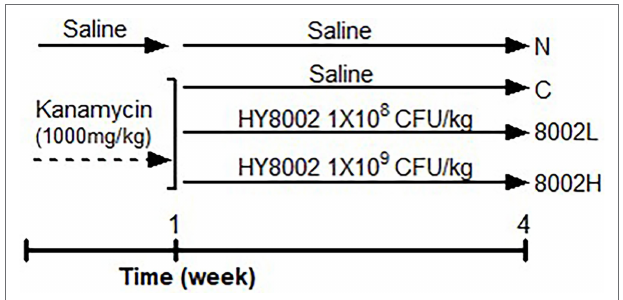
FIGURE 1 | Timeline and treatments of the animal experiments. N, normal group; C, kanamycin administration group; 8002L, kanamycin with 1.0 × 10 8